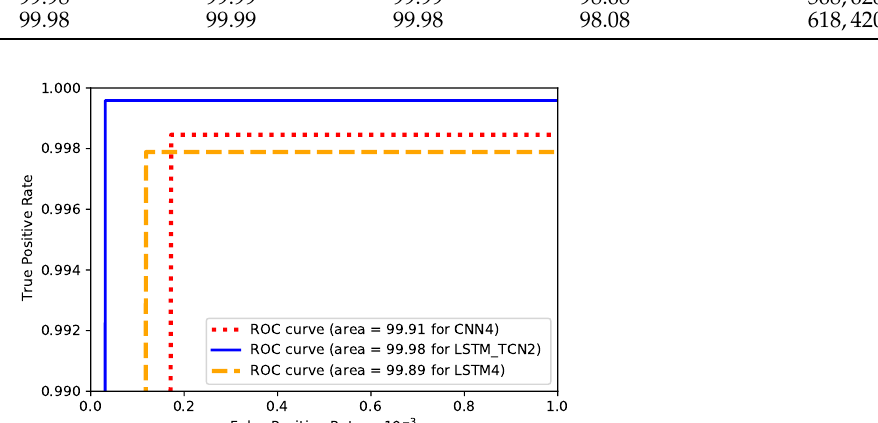
ROC curve (area = 99.91 for CNN4) ROC curve (area = 99.98 for LSTM_TCN2) ROC curve (area = 99.89 for LSTM4)